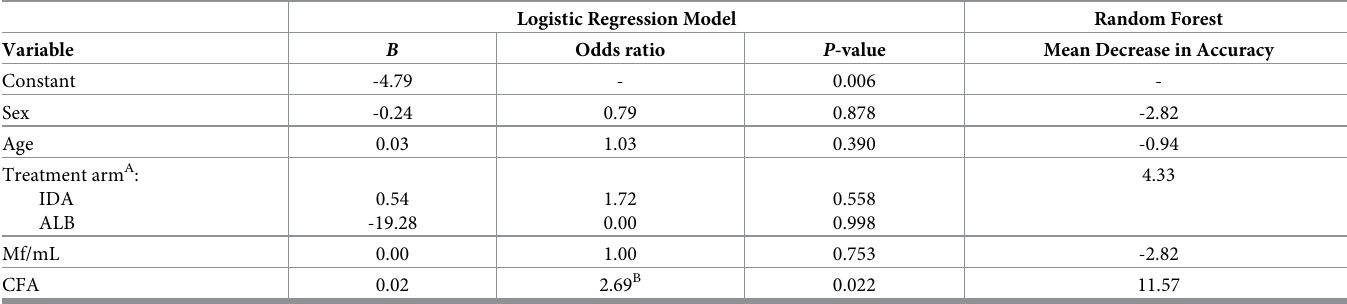
Table 3. Logistic regression and random forest analysis of sex, age, treatment arm and baseline infection parameters on the development of moderate adverse events. Logistic Regression Model Random Forest Odds ratio P -value Mean Decrease in